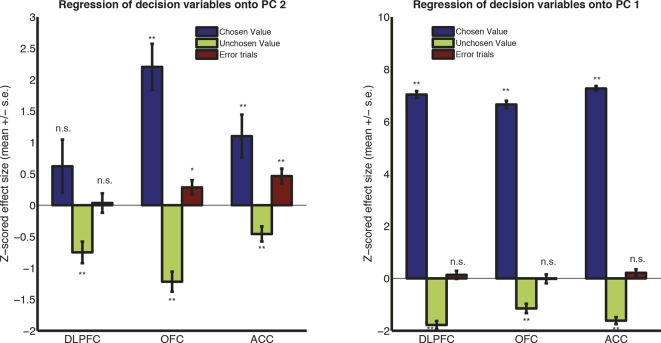
Regression of decision variables onto PC2 (left) and PC1 (right) in monkey K (free saccade).Monkey K was free to saccade during the 1s choice period, and made a joystick response rather than a saccade response after 1s had elapsed. Because of the different shape of the evoked response in monkey K (Figure 1—figure supplement 2) and the differences in PC1/2 timecourses as a consequence (Figure 2C), we here plot the effects of decision variables on PC weights separately for monkey K. (Note that PC1 still controlled waveform amplitude, and PC2 still controlled waveform latency, in this subject.) The effects of chosen value and error trials are similar for PC2 (left panel) as for other subjects (Figure 2E), but only reach significance in OFC and ACC. There is also a negative effect of unchosen value on PC2 in all regions, which is not clearly seen in other subjects (Figure 2E). However, the effects of chosen and unchosen value on PC1 (right panel) are highly significant, but not in the same direction as for other subjects (Figure 2. – figure supplement 5). We hypothesise that this is because in monkey K, PC1 is near zero during the early phase of the decision, but strongly modulated during the later phase (Figure 2C), which might imply a modulation by value difference as opposed to overall value.